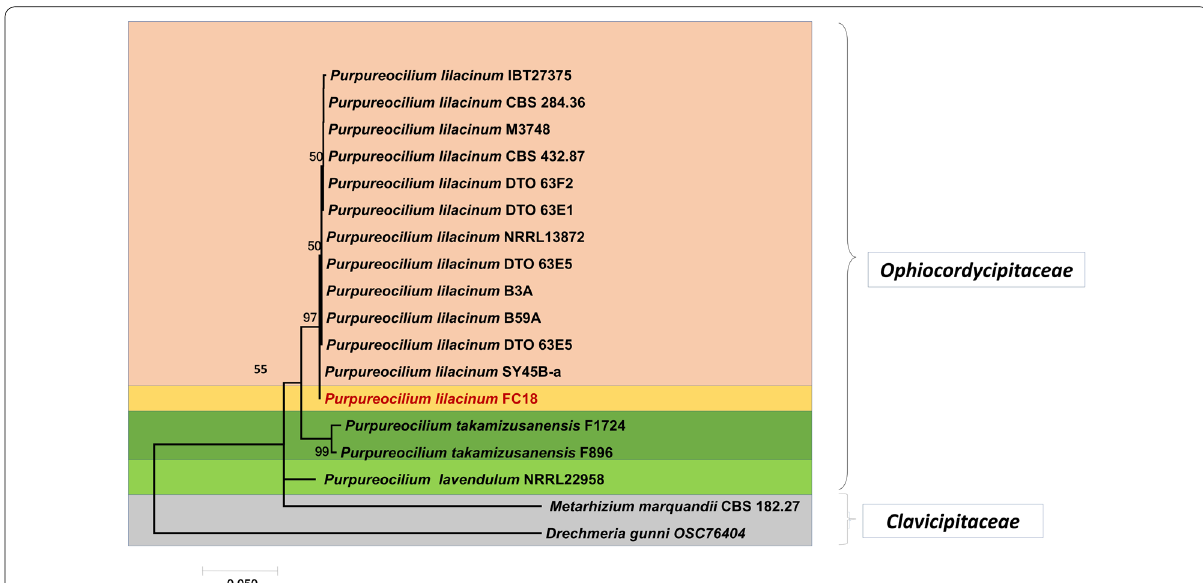
Fig. 4 Phylogenetic tree generated with maximum likelihood from concatenated ITS and β-tubulin sequences of Purpureocillium lilacinum using Tamura 2-parameter model having 18 taxa and 849 characters. The numbers at the nodes indicate bootstrap percentages. The isolate retrieved in this study is in bold